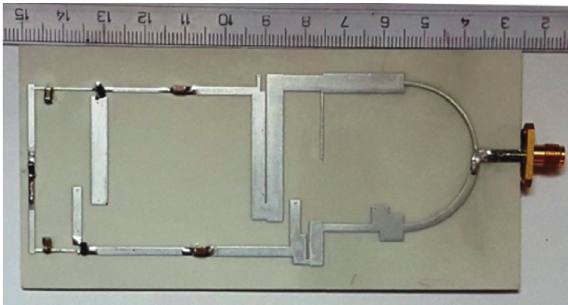
Figure 10: Photograph of the fabricated proposed rectifier.